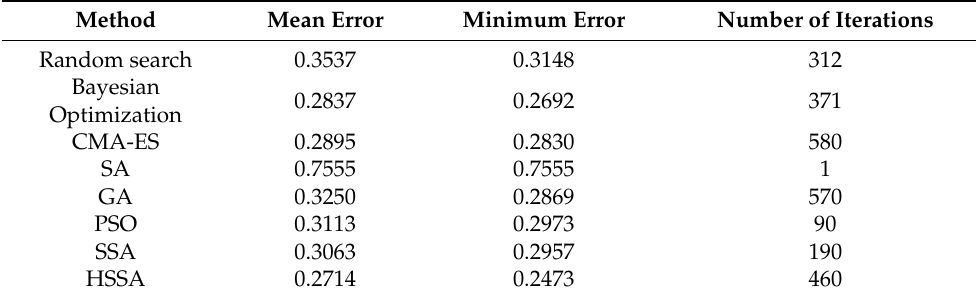
Table 10. Results analysis on Five Flowers.